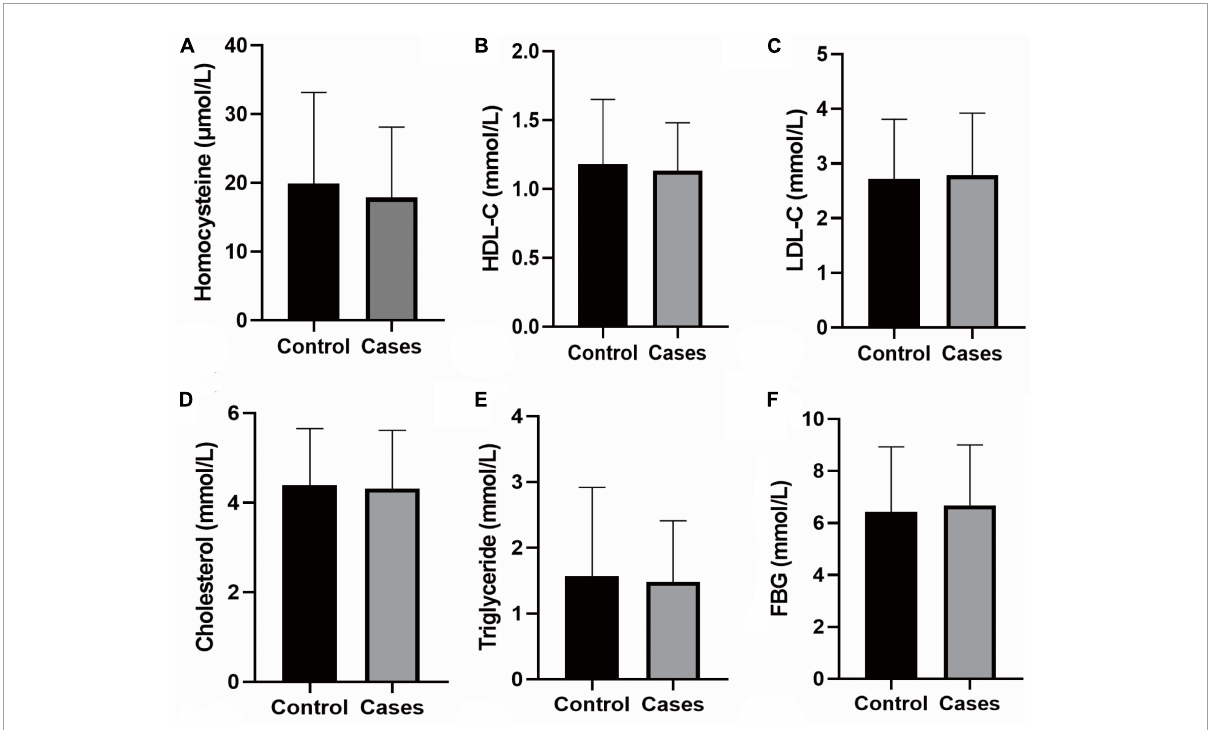
FIGURE2 Biochemical tests. (A) The level of Homocysteine; (B) the level of HDL-C; (C) the level of LDL-Cs; (D) the level of Cholesterol; (E) the level of Triglyceride; (F) the level of FBG; the data shown in the graphs represent the mean ± SD. FBG, fasting blood-glucose; LDL-C, low density lipoprotein cholesterol; HDL-C, high-density lipoprotein cholesterol; SD, standard